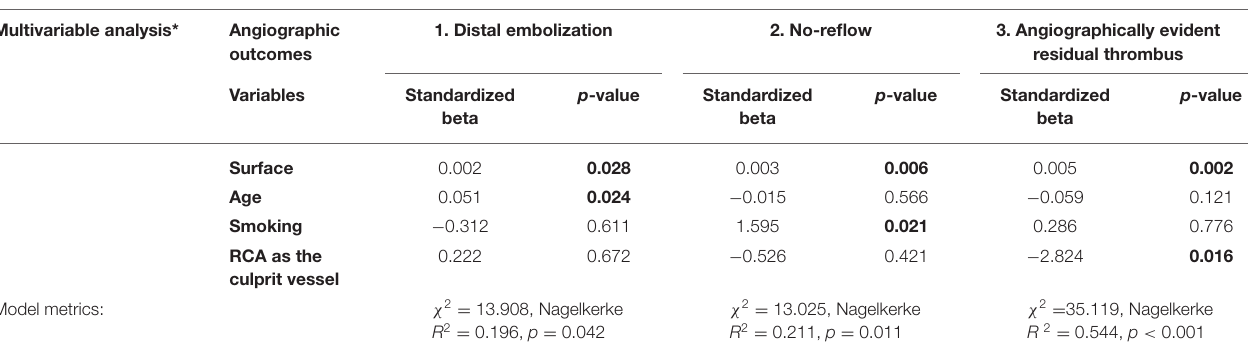
TABLE 6 | Association of extracted thrombus surface with angiographic outcomes. Multivariable